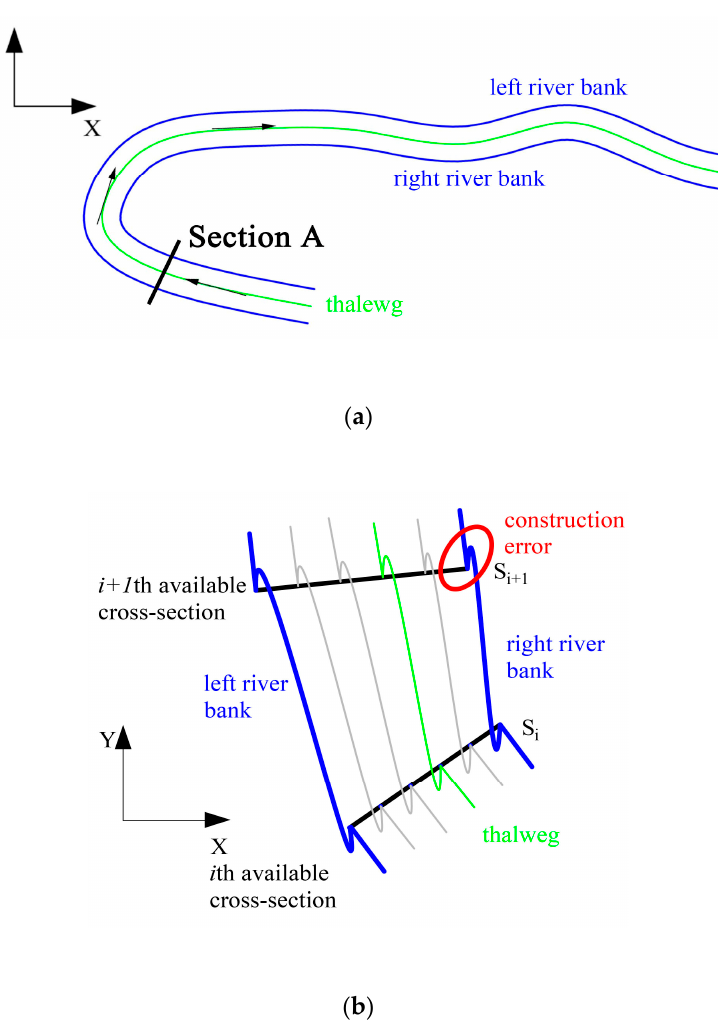
Figure 1. ( a ) Meandering river channel and ( b ) erroneous river trend constructed by using the Cubic Hermite Spline (CHS) method.